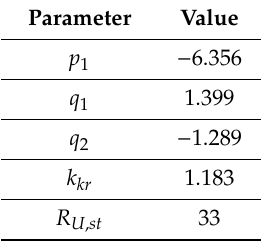
Table 1. Parameters of model of voltage range in PEM fuel cell